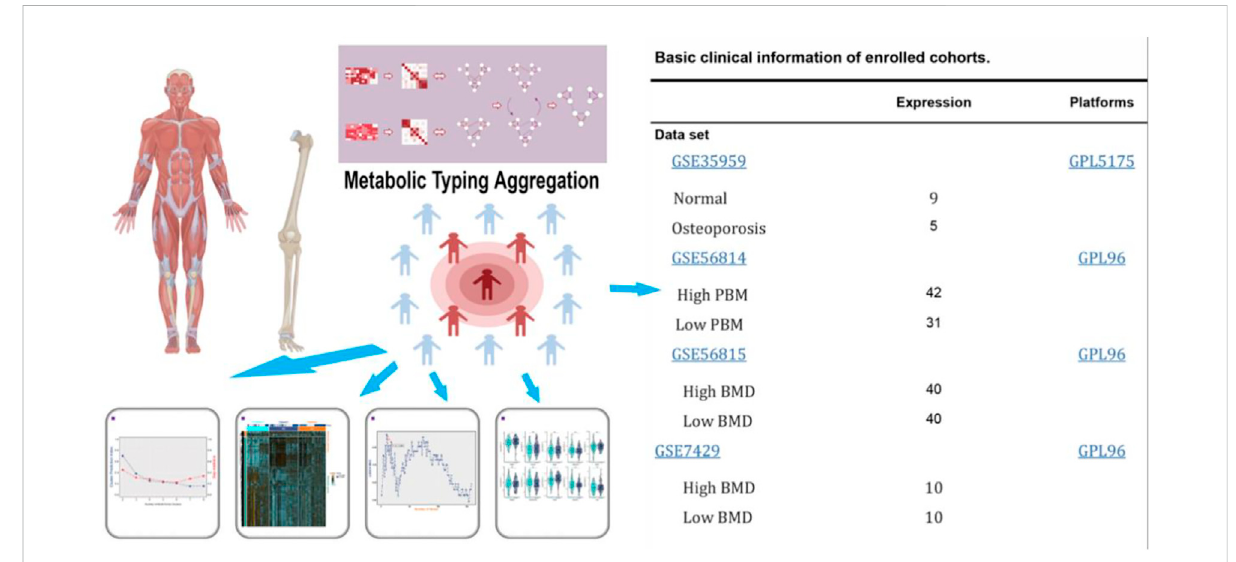
FIGURE 1 Flow diagram of the present study. The selected dataset contains the number of samples and